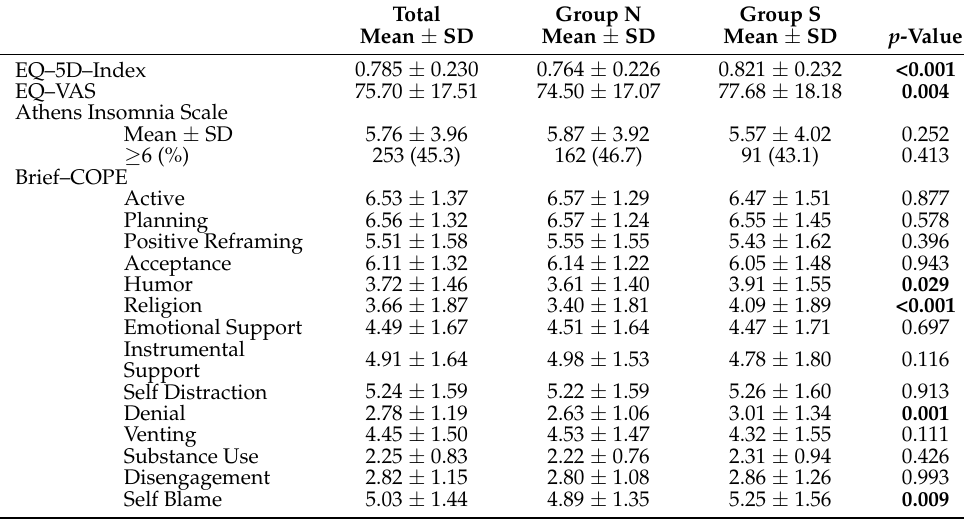
Table 2. Mean scores of validated questionnaires assessing health-related and perceived quality of life, insomnia, and coping strategies in healthcare personnel during the first wave of COVID-19 pandemic ( n = 558).